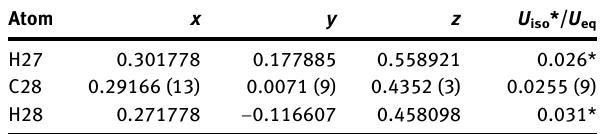
Table  : Fractional atomic coordinates and isotropic or equivalent isotropic displacement parameters (Å 